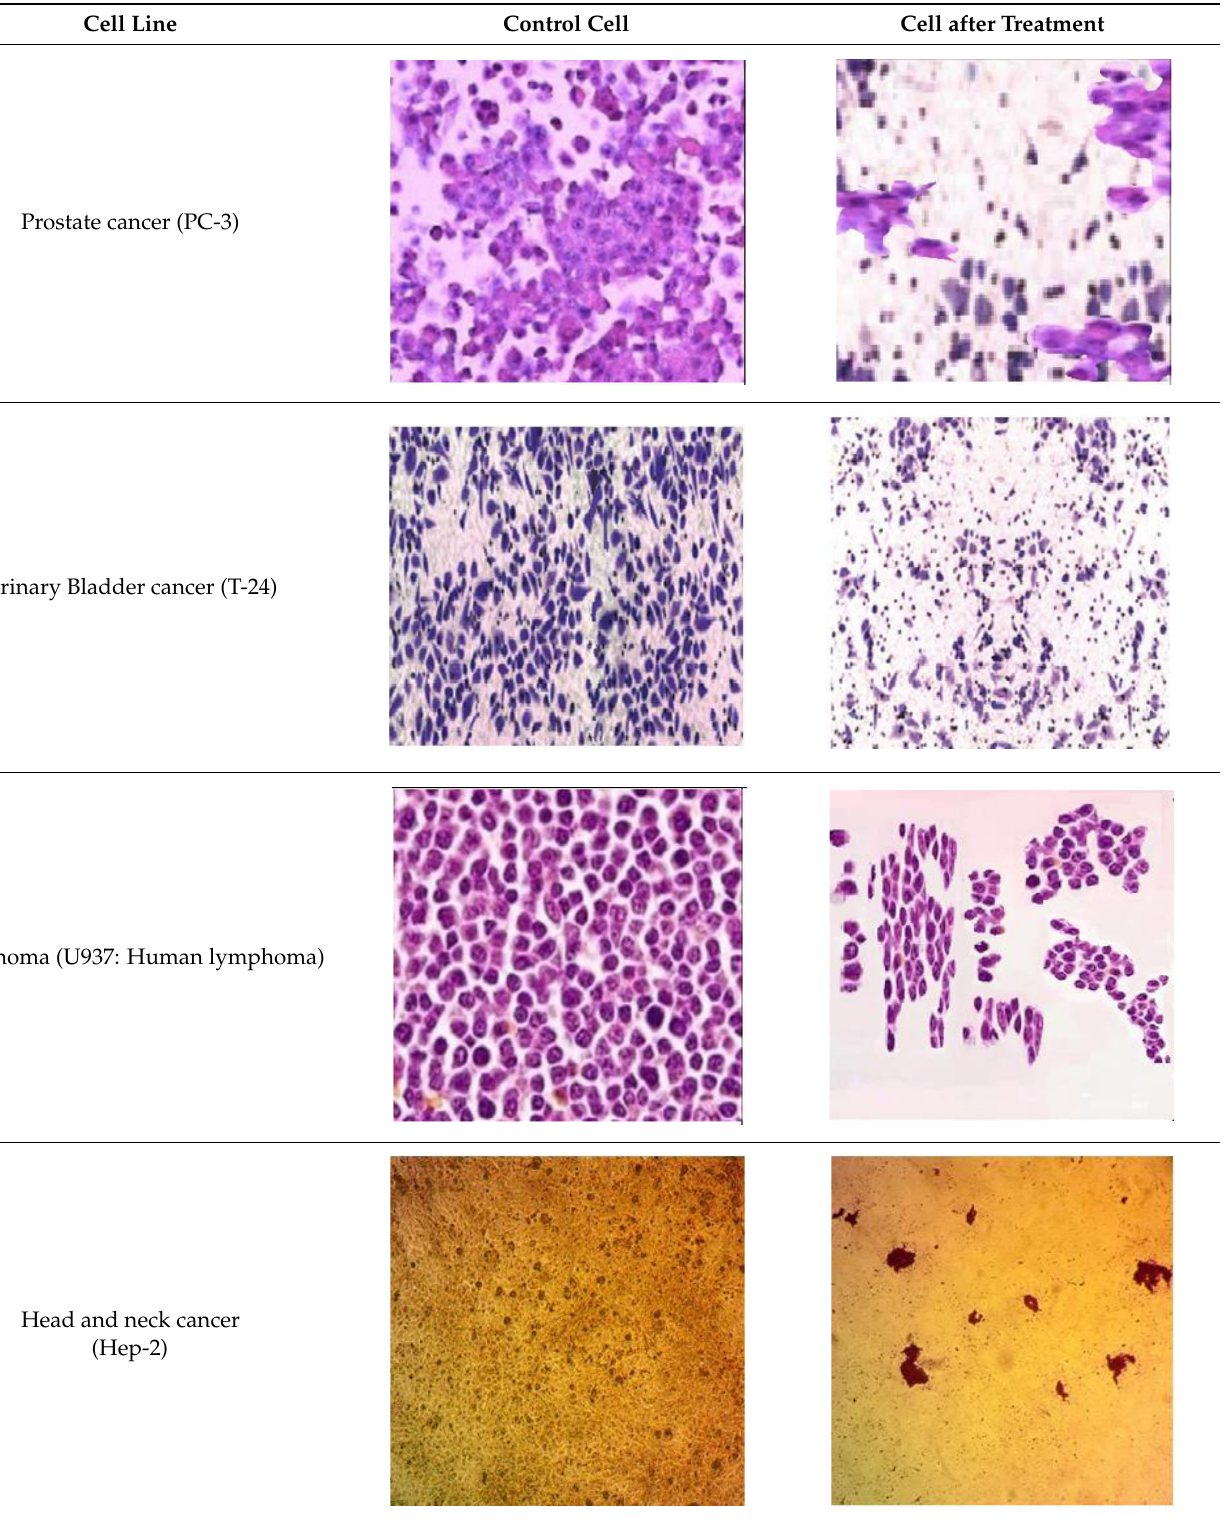
Table 3 and Figure 3 show the inhibitory impact of P. amygdalus var . amara on right cancer cell lines at several concentrations (5–300 µg/mL). Table 3. Anti-cancer impacts of P. amygdalus var . amara alcoholic seed extractions.